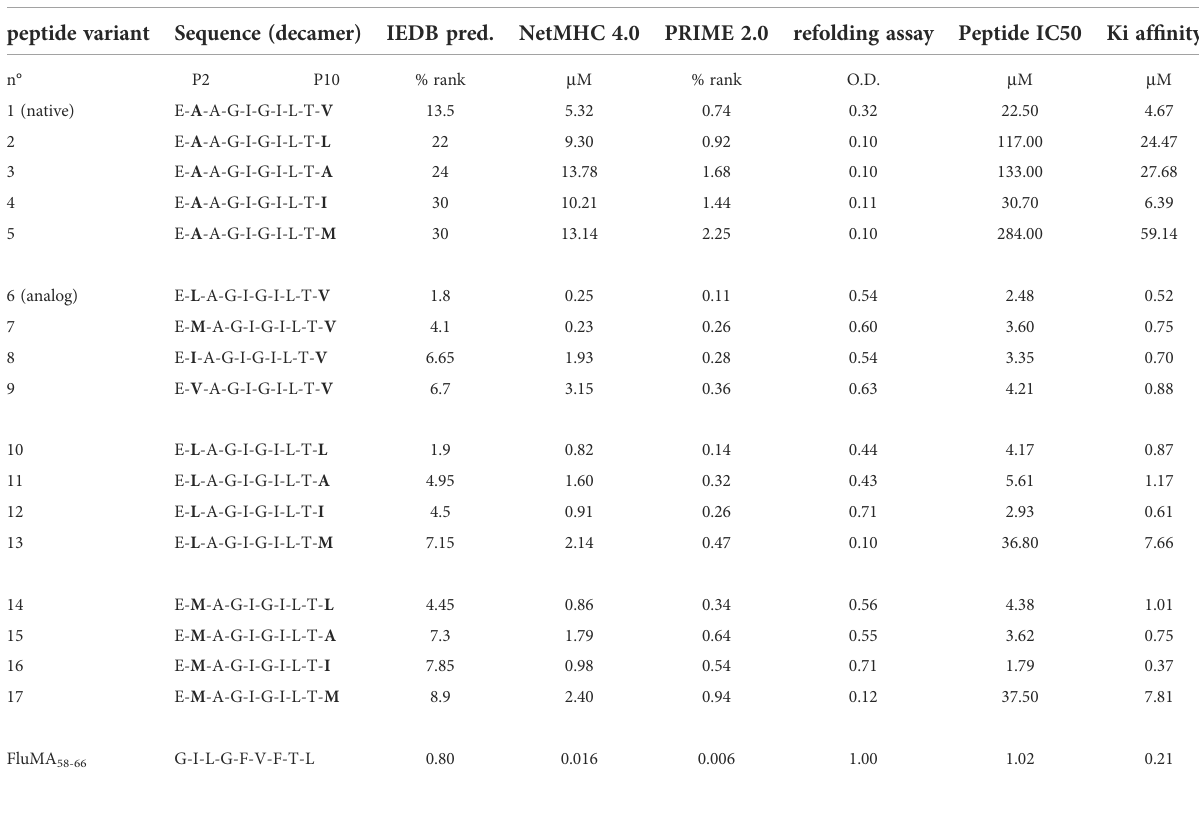
TABLE 1 Sequences, algorithm-based and biophysical values of HLA-A*0201-restricted Melan-A/MART1 26-35 P2/P10 peptide variants and Flu Matrix 58-66 control. Melan-A/MART-1